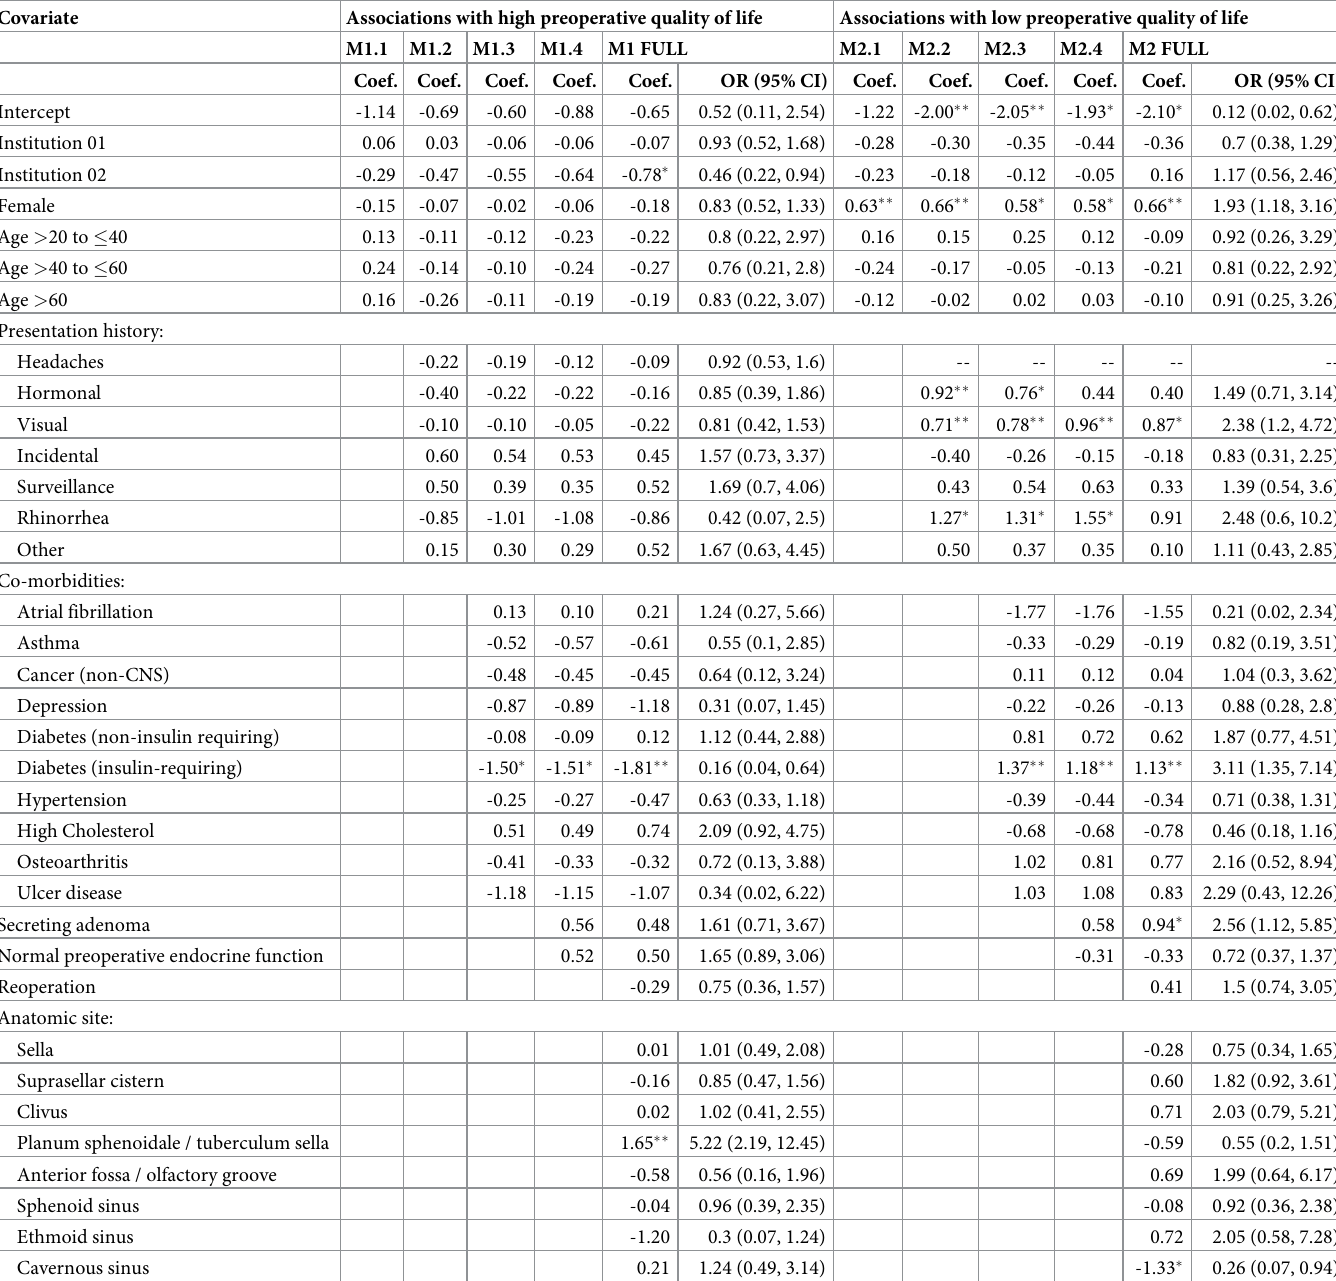
Table 2. Multivariate logistic regression showing associations between covariates and preoperative ASBS quality of life scores (top quartile). � p < 0.05. �� p < 0.01. The MX.X numbers are model codes. M1 stands for model 1, which was designed to detect associations with high preoperative QoL. M1.1 is the first iteration of model 1, M1.2 is the second iteration of model 1, and so on. The MX FULL model contains all covariates. Covariate Associations with high preoperative quality of life Associations with low preoperative quality of